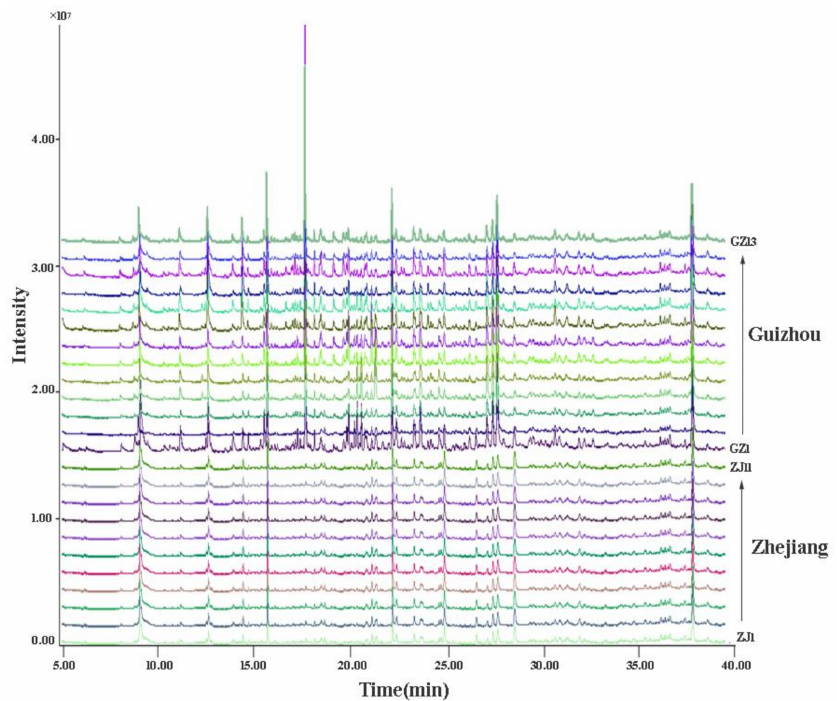
Figure 2. Typical chromatogram of the volatile components from Selaginella doederleinii by headspace